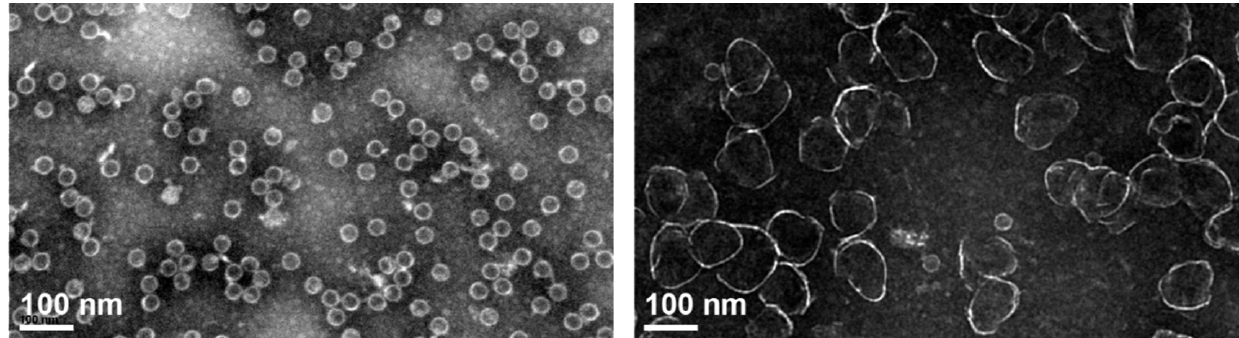
Figure 9. Typical impact of a CAM-A compound on in vitro assembly of Cp149. E. coli derived Cp149 CLPs were disassembled and reassembled in the absence (left) or presence (right) of an experimental CAM-A compound, JNJ 890, at a molar Cp:compound ratio of 2:1. Samples were analyzed by negative staining EM and are shown at identical magnification. Formation of large flat aggregates is a hallmark of CAM-A compounds; CAM-E compounds would not produce a particle phenotype that can be distinguished by this technique. Figure courtesy of Lauriane Lecoq and Anja Böckmann .